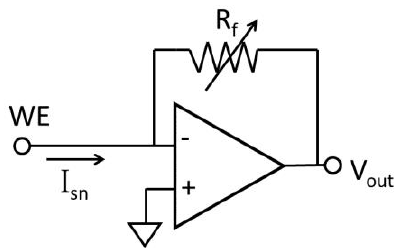
Figure 7. Resistive feedback current readout circuit.